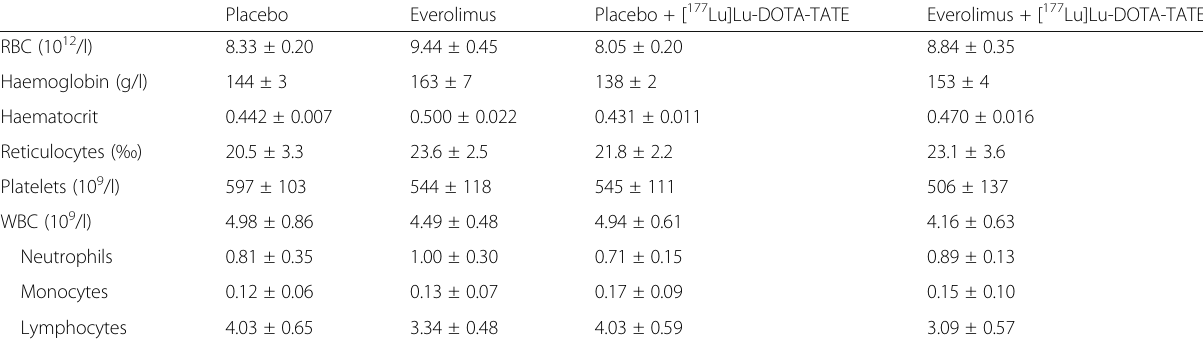
Table 4 Overview of the haematologic parameters measured in the first part of the study at week 16. The ranges mark the 95% confidence intervals